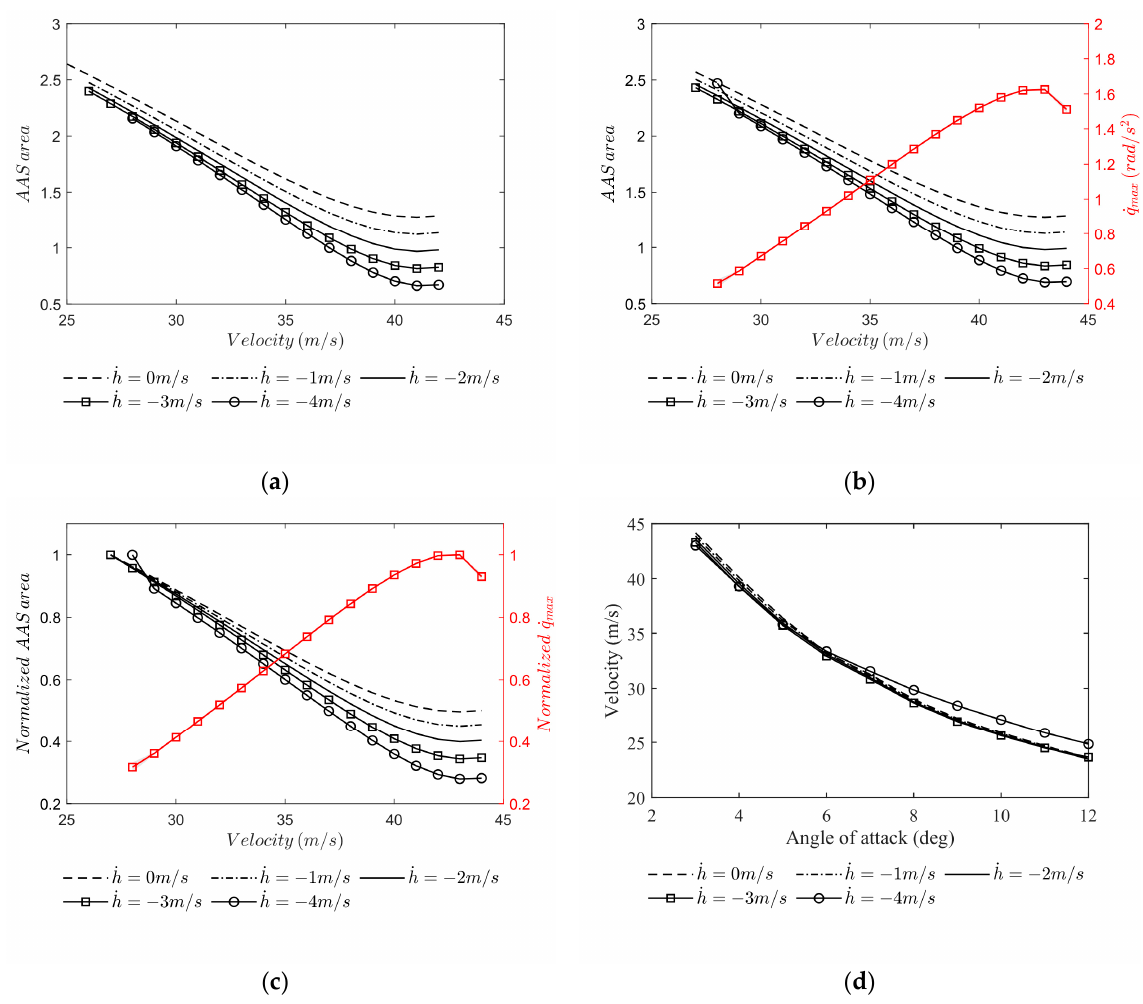
Figure 11. AAS and AMS calculation for short landing (angle of attack = 6 deg): ( a ) AAS area results, ( b ) AAS area and AMS results, ( c ) normalized AAS area and AMS results, and ( d ) equilibrium points for different sink rates.